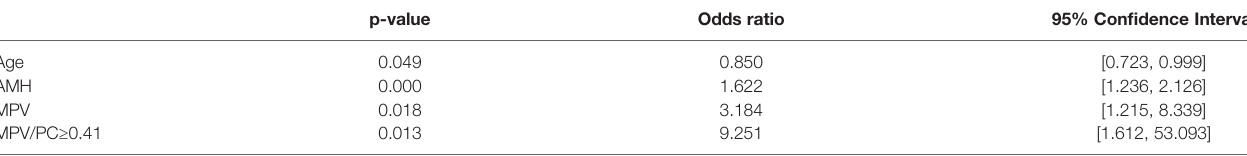
TABLE 6 | Logistic regression analysis of factors affecting acquisition of 10 or more MII